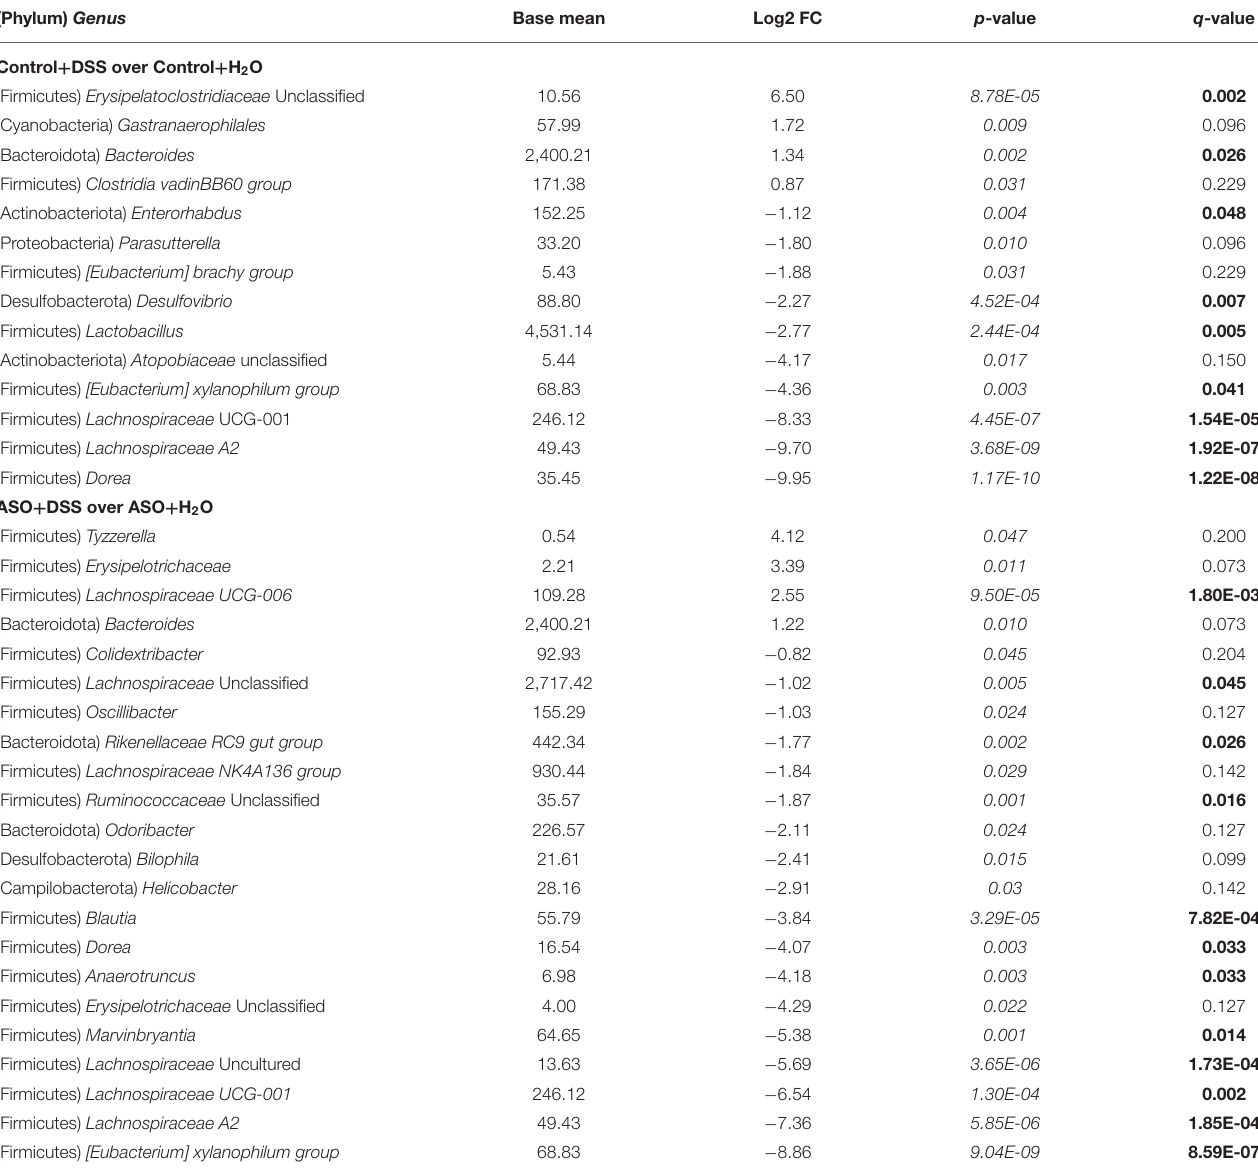
TABLE 2 | Genus taxonomic level differential abundance DeSeq2 analysis between control or ASO mice treated with water and dextran sodium sulfate. (Phylum) Genus Base mean Log2 FC p -value q